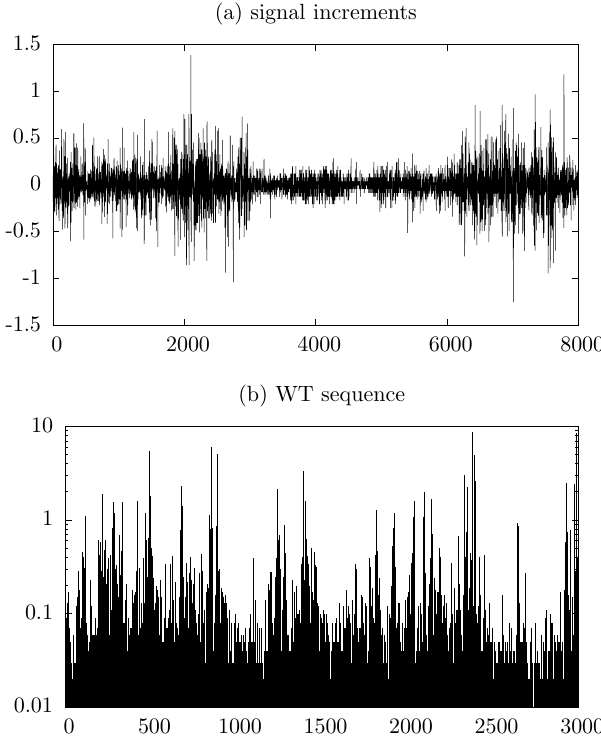
Fig. 2. Samples from (a) time series of increments of the normal- ized fluctuation e U x (t) ; (b) sequence of Waiting Times for threshold passages of 1S = 1U x ( D 0 = 0 .